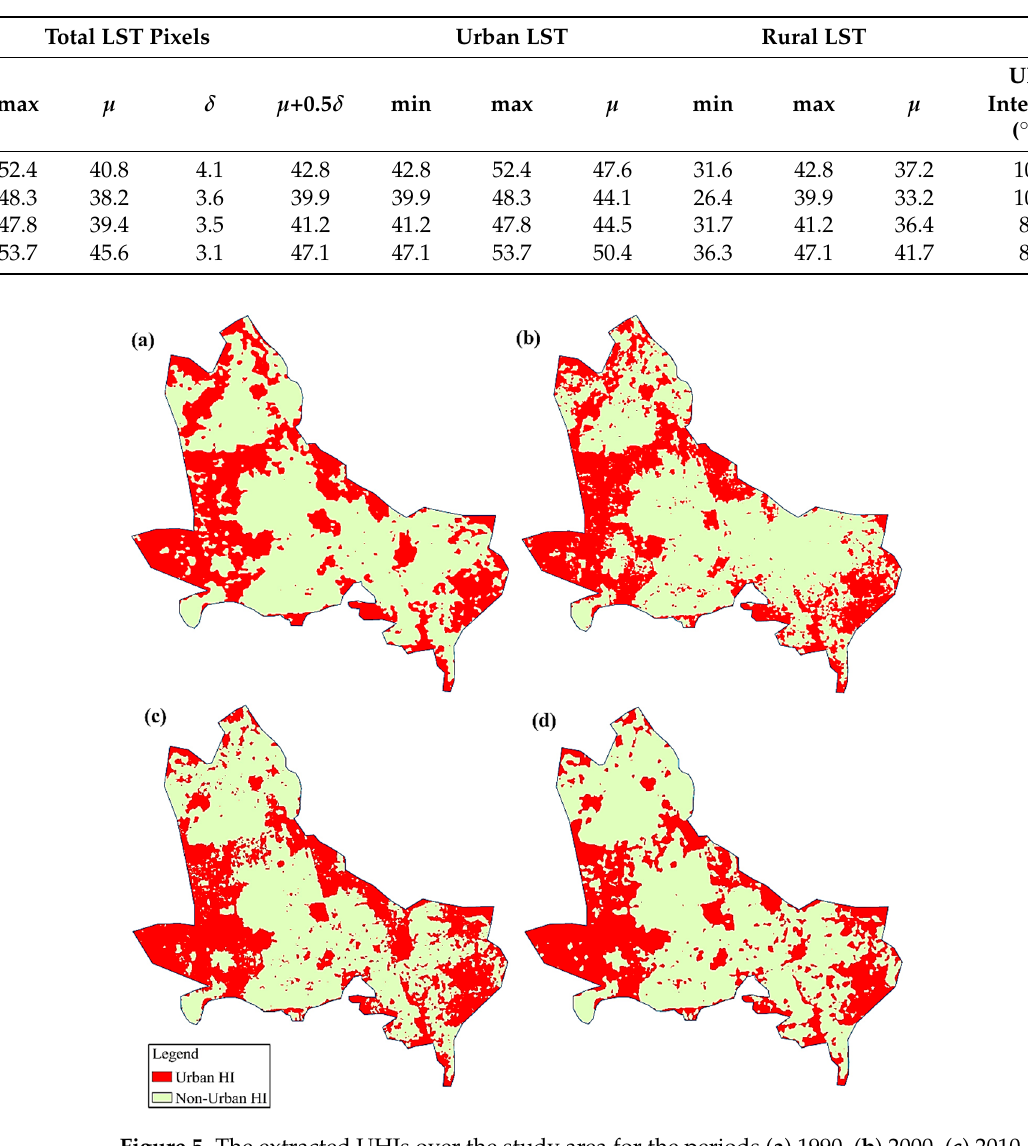
Table 4. The assessment of intensity of UHIs over the multiple surface covers of the study area.